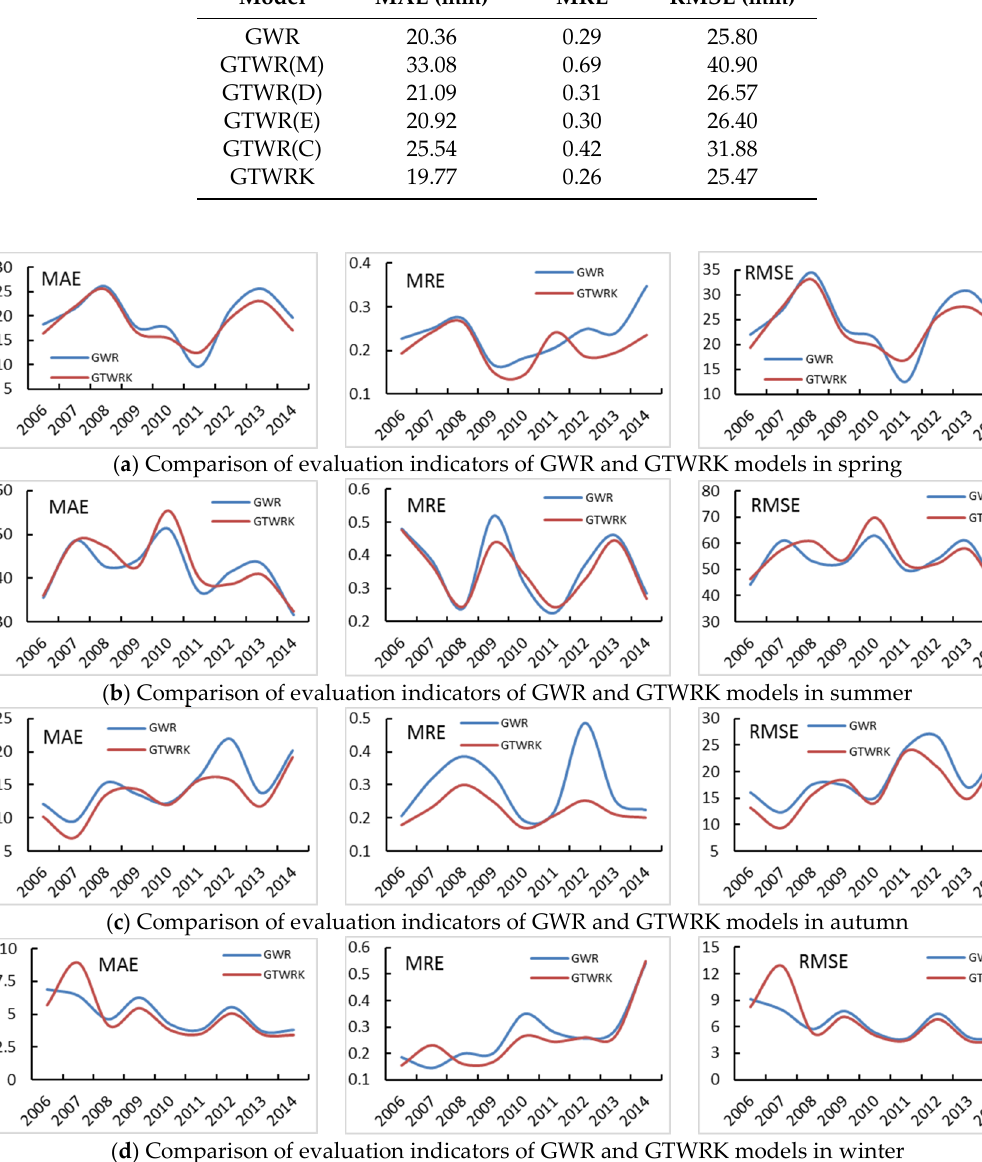
Figure 7. Applicability of GWR and GTWRK models in different seasons. ( a – d ) represent the distribution chart of MAE (Units: mm), MRE, and RMSE (Units: mm) in the four seasons, respectively.